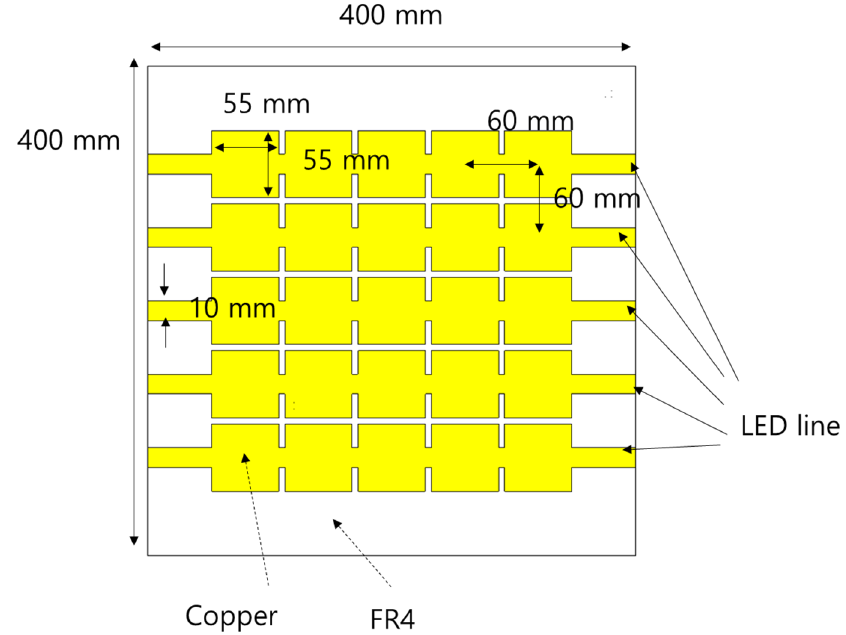
Figure 6. Top view of the proposed PRS.